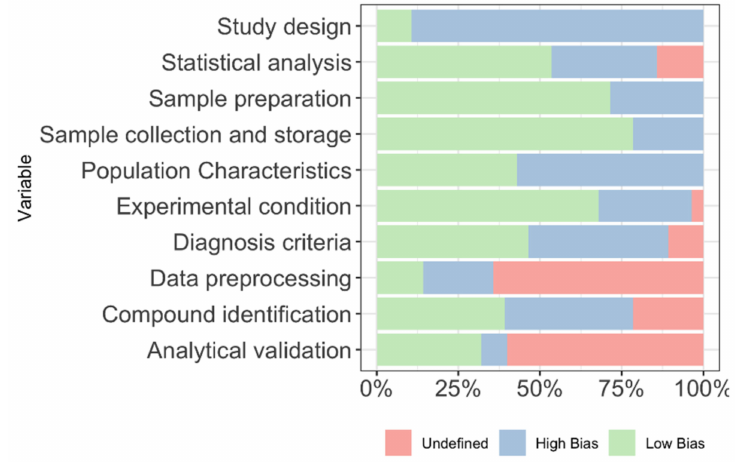
Figure 3. Quality assessment results for the included